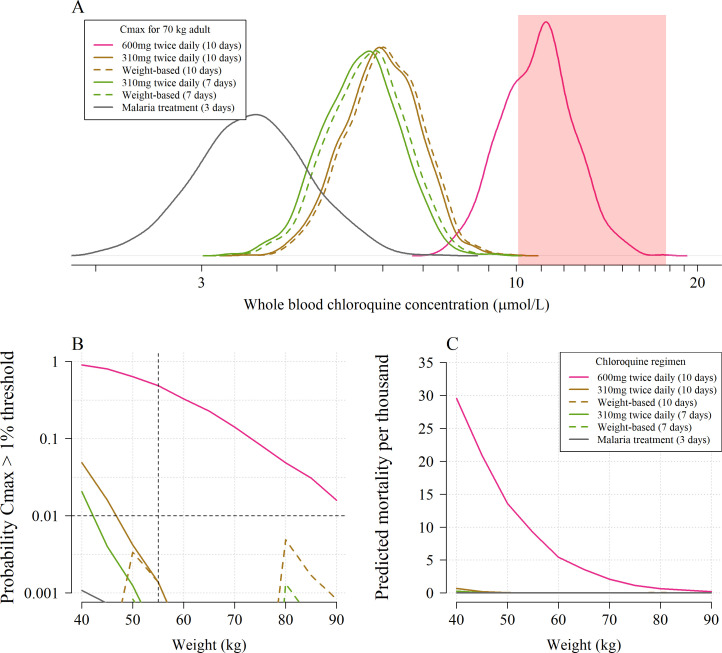
The predicted risk of fatal toxicity across the six chloroquine regimens simulated under the plasma pharmacokinetic model.Panel A shows the simulated distribution of Cmax values in a 70 kg adult for the six regimens considered. The vertical red shaded area shows the 95% credible interval for the 1% mortality threshold concentration. Panel B shows the probability that an individual will cross the 1% mortality threshold value as a function of body weight for the different regimens (log10 scale on the y-axis). Panel C shows the predicted mortality per thousand for the six regimens as a function of body weight.